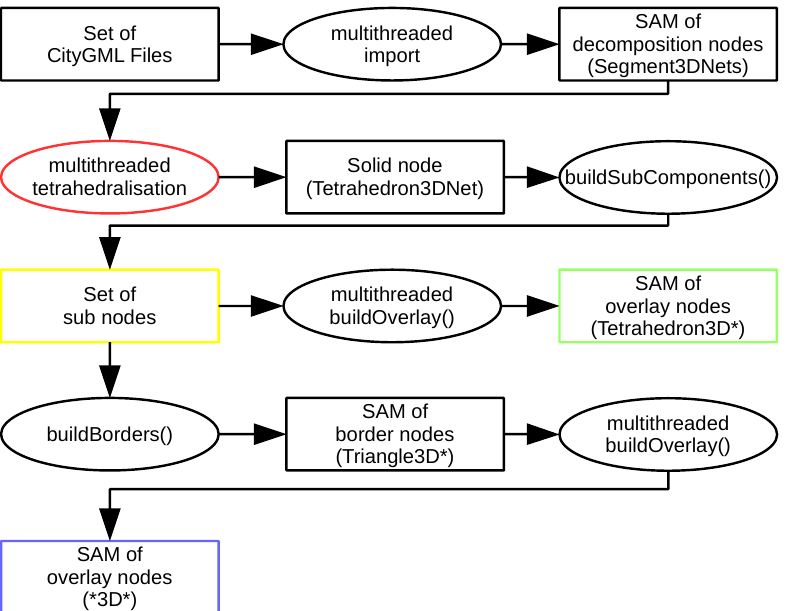
Figure 8. Pipeline to build one run of the sensitivity analysis. The “*” within the green box and the black box indicates that the SAM may contain multiple aggregation levels (e.g., single simplex, simplex complexes or simplex nets as the topological sum of a set of simplex complexes). The first “*” within the blue box indicates that the SAM may contain multiple dimensions (e.g., samples, curves and surfaces). The second “*” indicates the aggregation